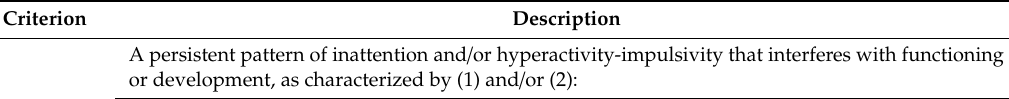
Table 1. DSM-5 Criteria for Attention-deficit / hyperactivity disorder